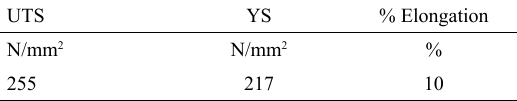
Table 2. Mechanical Properties of AZ31B Mg alloy.